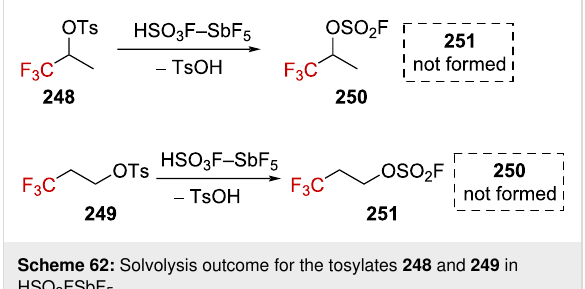
Scheme 62: Solvolysis outcome for the tosylates 248 and 249 in HSO